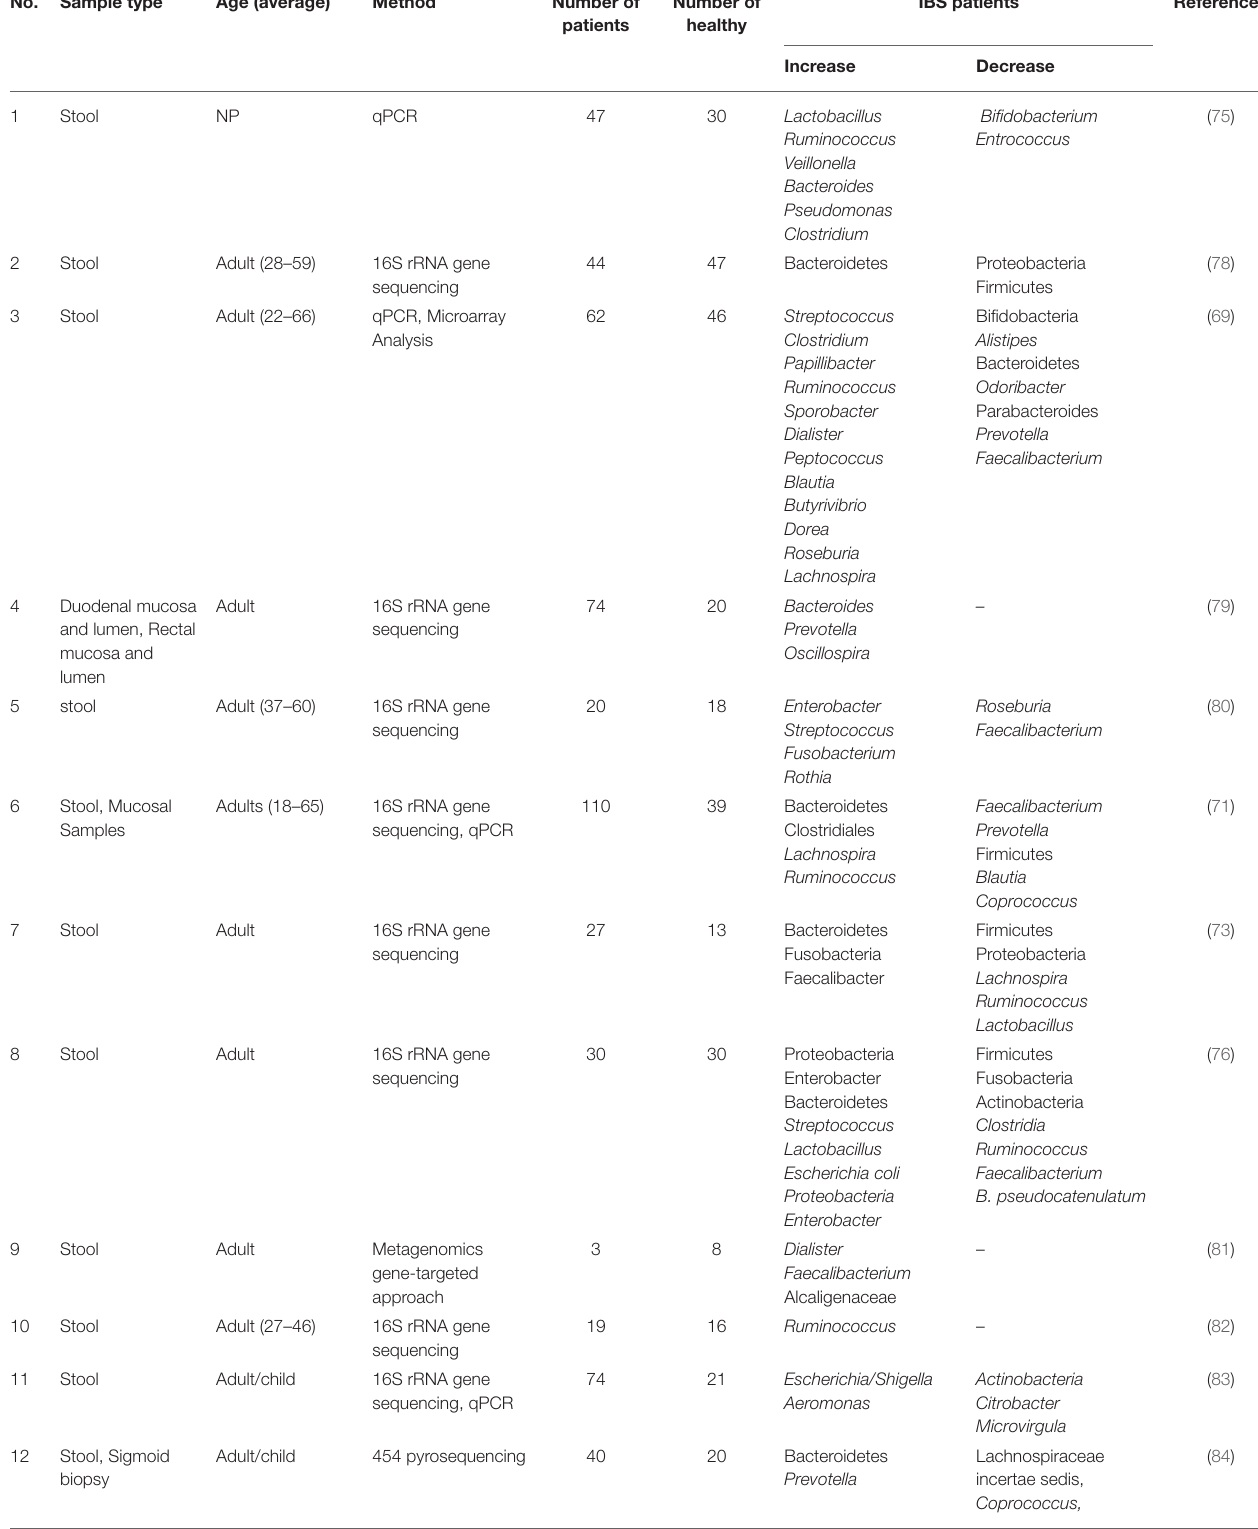
TABLE 1 | The gut microbiota changes in patients with